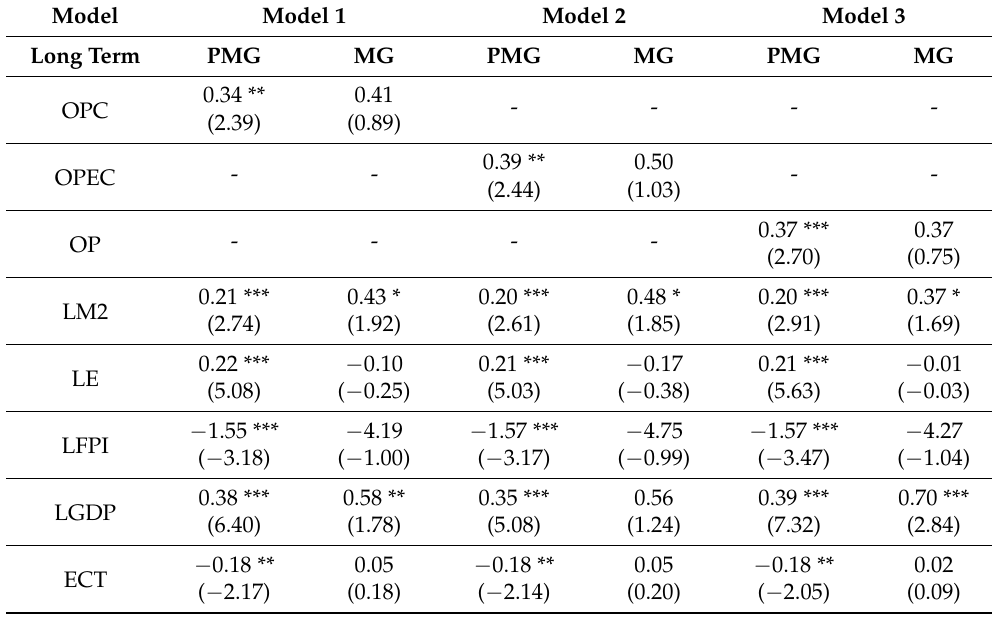
Table A3. The linear PMG and MG